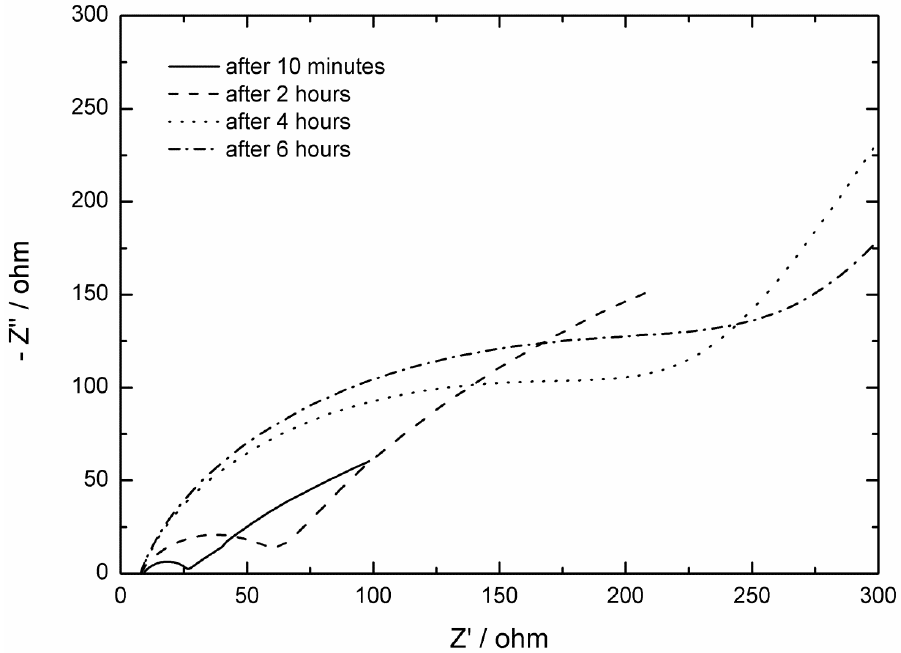
Figure 12. Selection of Nyquist plots of Li in EC:DEC (3:7, by wt.) as electrolyte of a symmetrical cell of deposited lithium on LiPF 6 a copper foil (0.36 As cm − 2 ). The AC impedance measurements were carried out after 10 min, after 2 h, after 4 h and after 6 h during immersion time of the deposited lithium in the